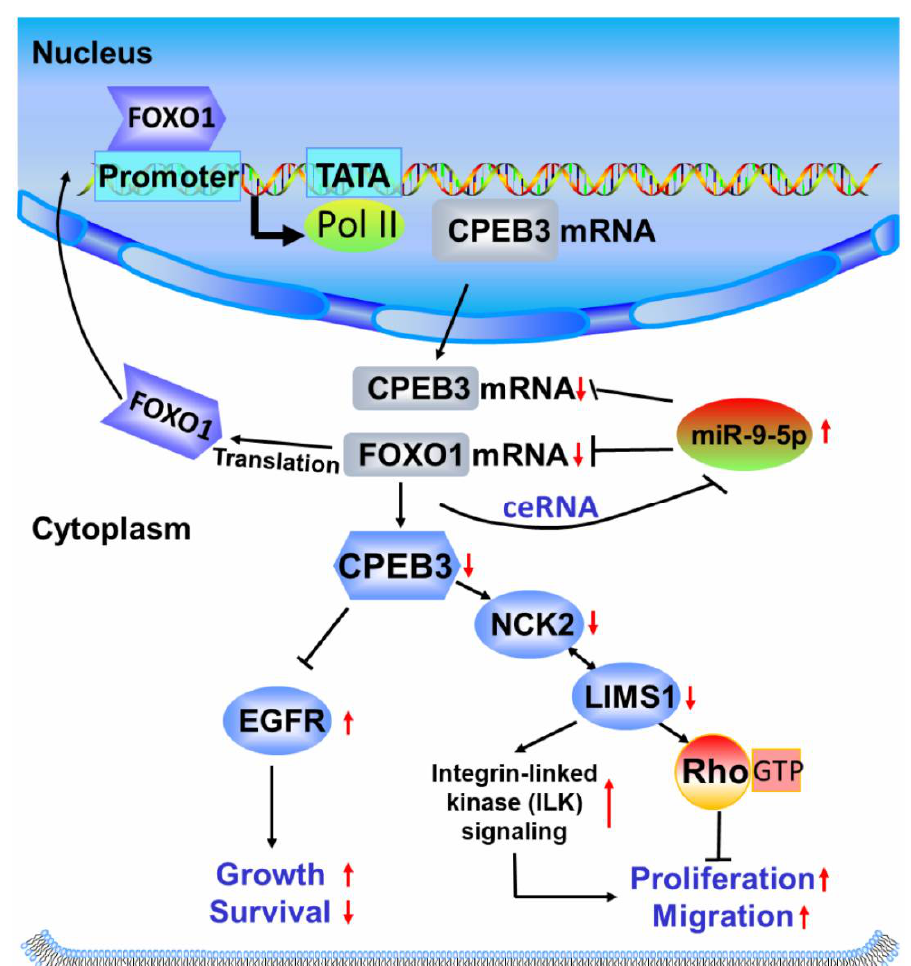
Figure 6. A potential pathway mediated by miR-9-5p/FOXO1/CPEB3 FFL. Schematic illustration of miR-9-5p/FOXO1/CPEB3 FFL and its possible downstream pathways in hepatocellular carcinoma. Up arrows represent increased gene expression ( CPEB3 , FOXO1 etc.) and indicated pathway effects (tumor growth, proliferation etc.), while down arrows represent decreased gene expression and indicated pathway effects. ceRNA: competing endogenous RNA.